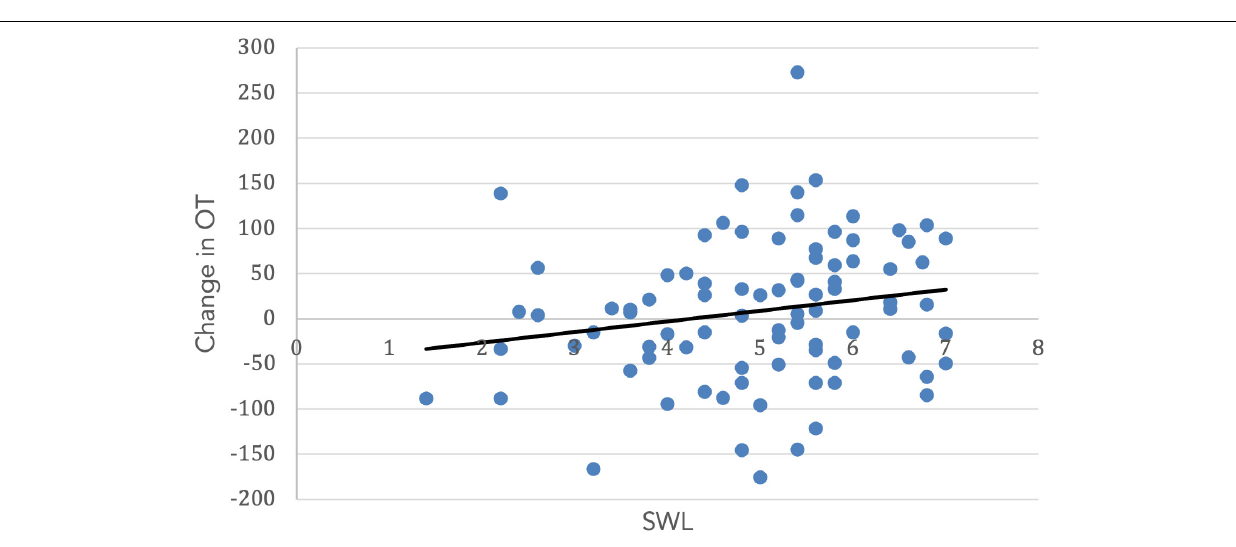
FIGURE 5 | The change in OT had a positive correlation with satisfaction with life ( r = 0.20, p =